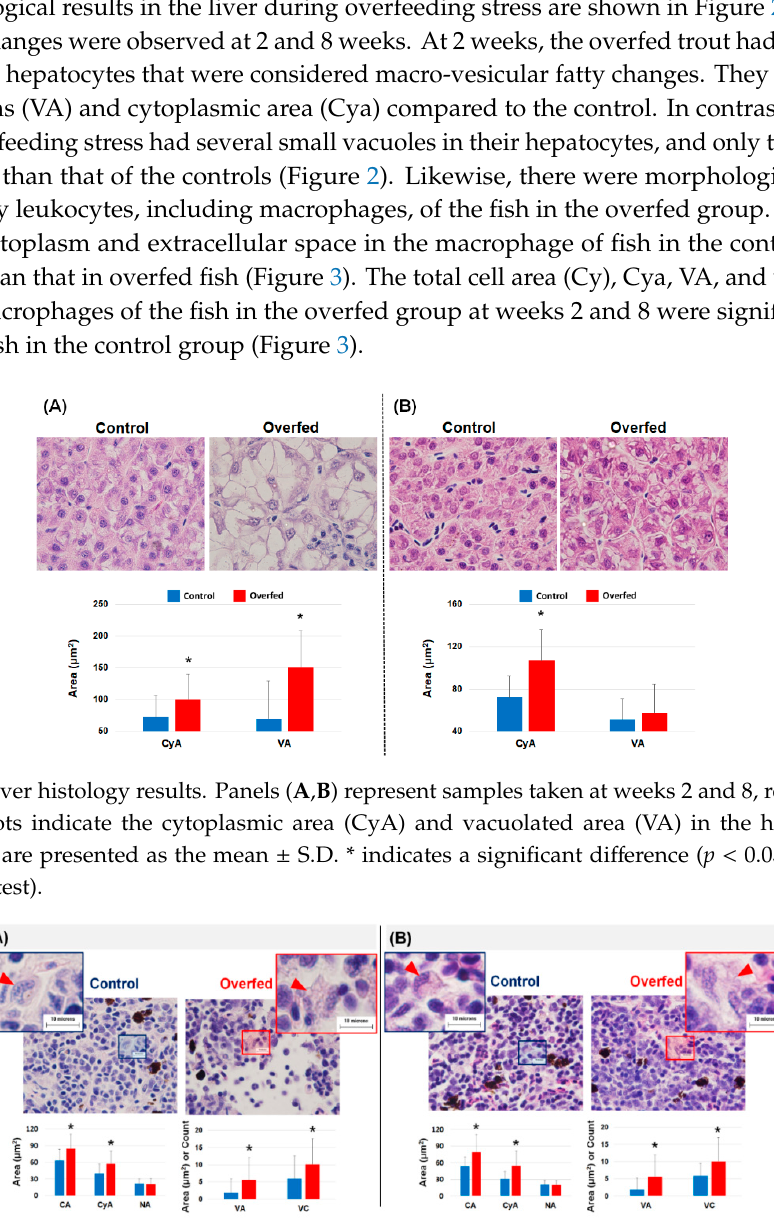
Figure 3. The morphological characteristics of macrophages in head kidney based on histological results. The red triangles indicate macrophages. The leukocytes in overfed trout contained much larger cytoplasmic fat vacuoles with ambiguous boundaries between the cytoplasm and extracellular space. Panels ( A , B ) show samples taken at weeks 2 and 8, respectively. The total cell area (CA), cytoplasmic area (CyA), nuclear area (NA), vacuolation area (VA), and vacuole count (VC) in the macrophages are presented in bar plots. The blue and red bars indicate fish in the control and overfed groups, respectively. The results are presented as mean ± S.D. * indicates a significant difference ( p < 0.05 based on student’s t -test).